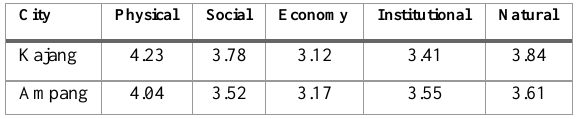
Table 2: Overall CDRI Analysis. Source: Research fieldwork -